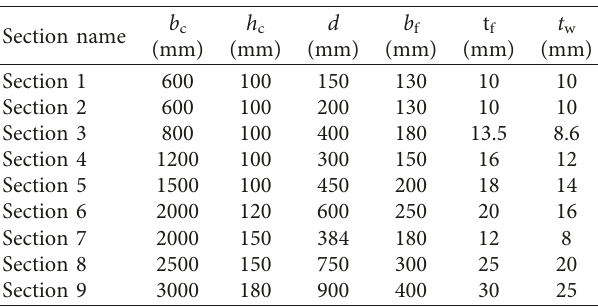
Table 3: Parameter study (cross-sectional data).